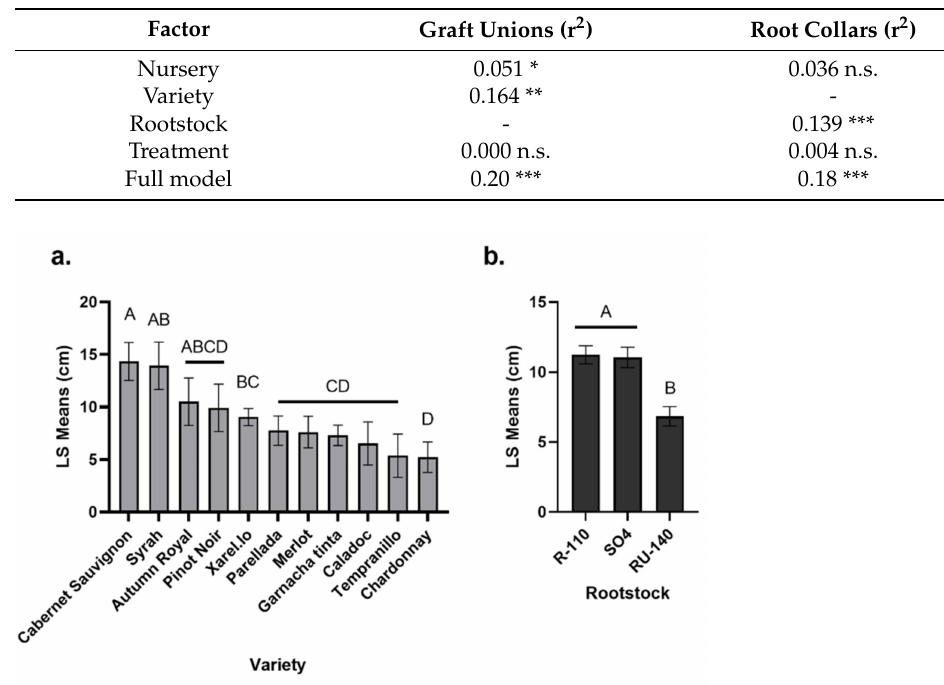
Table 2. Contribution (r 2 ) of nursery, variety/rootstock, and treatment to the variation in necrosis in graft unions and root collars. The annotation following the r 2 values indicates the significance level: